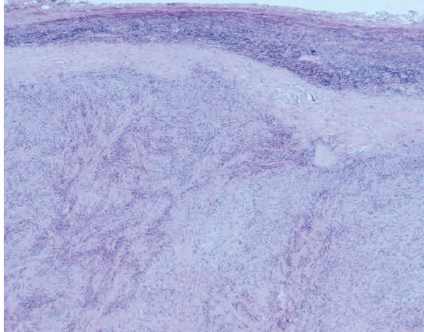
Figure 2: Fusocellular proliferation encapsulated by a thick fibrous capsule compressing the nodal tissue (HE, 100x).